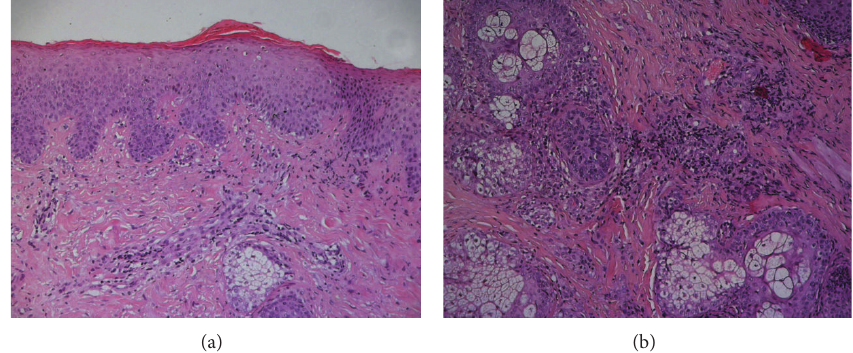
Figure 2: (a) The epidermal layer is characterized by a mild degree of papillomatosis, acanthosis, and focal mixed orthokeratotic and parakeratotic hyperkeratoses. The underlying papillary and reticular dermis shows a marked fibrotic change associated with a chronic mononuclear perivascular inflammatory infiltrate (H&E, 100x magnification). (b) A moderate mononuclear chronic infiltrate is present around adnexal structures (H&E, 100x